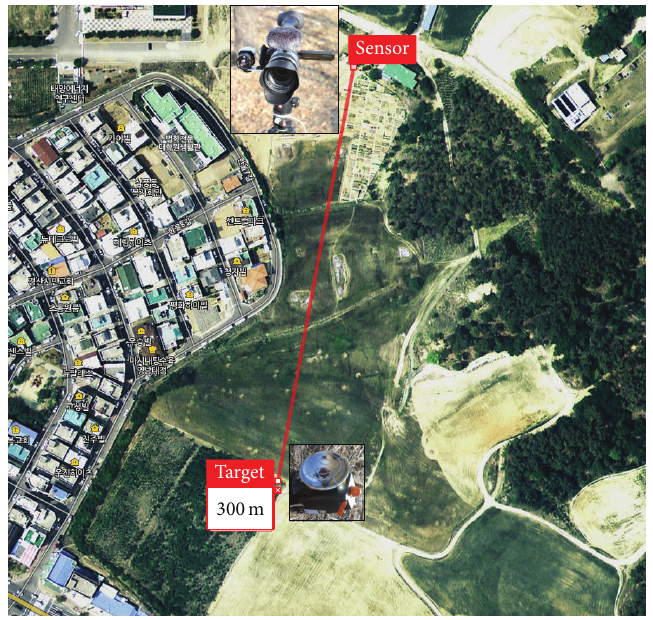
Figure 5: Overview of the target and sensor